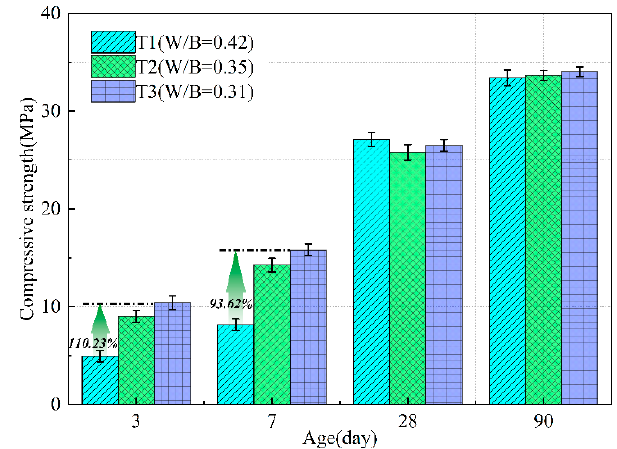
Figure 7. Compressive strengths of mortars with different W/B ratios at different